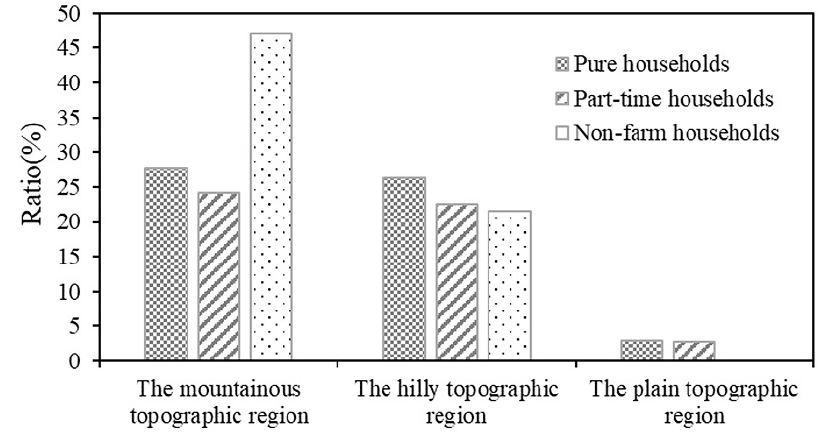
Figure 2. Characteristics of cropland abandonment by diverse farming households in three topo- graphic regions.